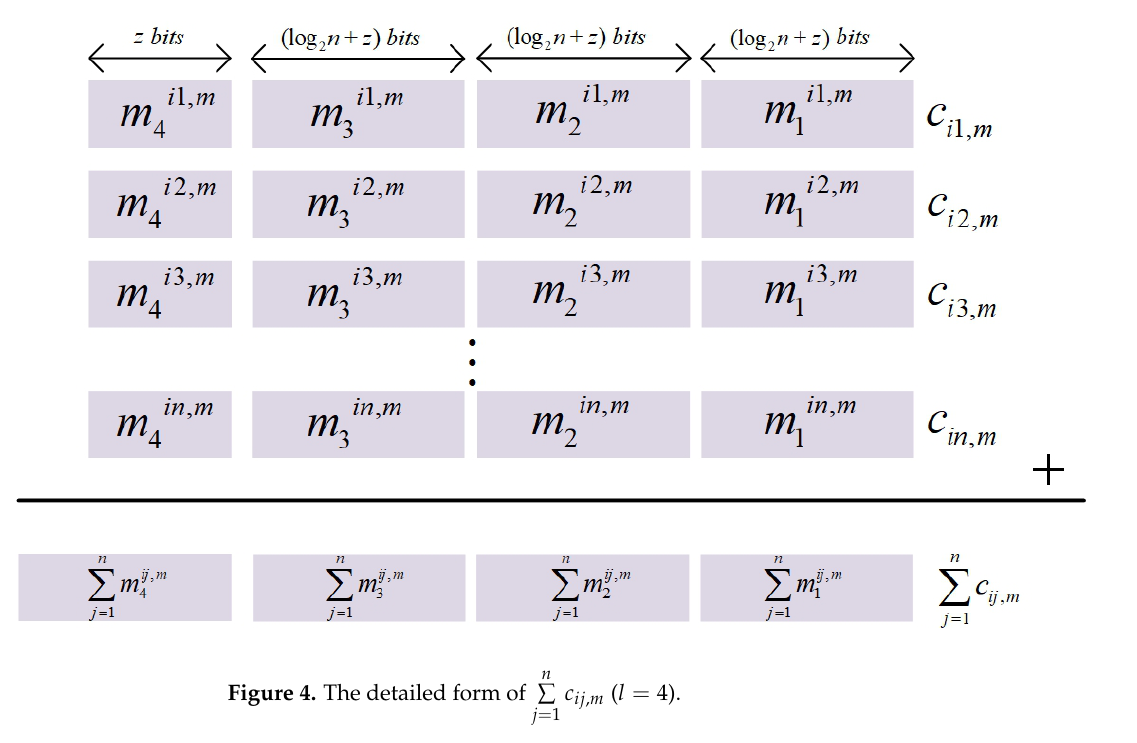
Figure 4. The detailed form of